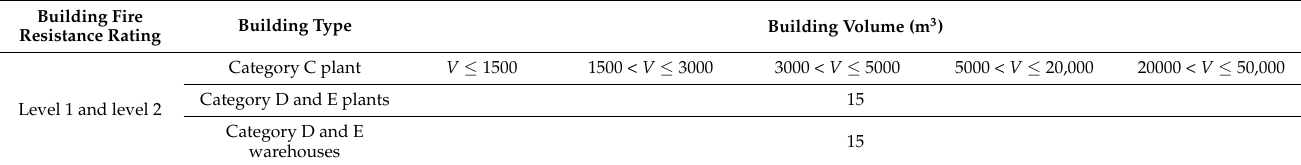
Table 12. Required water flow for outdoor fire protection (L/s) [58].